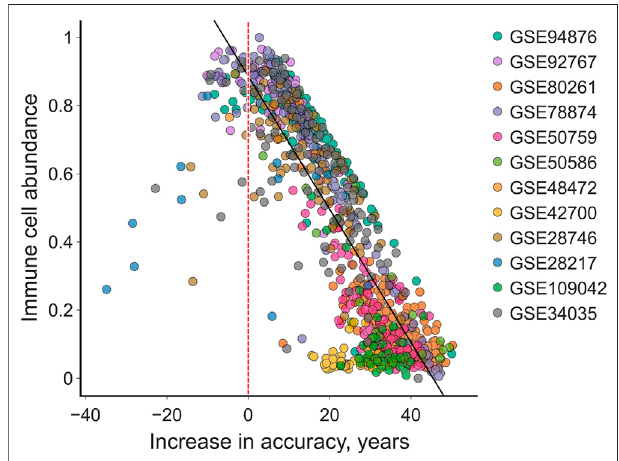
FIGURE 4 | The “ total age-transformed ” adjustment increases the age prediction accuracy in individual samples by up to 50 years in saliva samples. The absolute increase in accuracy is smaller in samples with higher immune cell count. Very few (5%) samples are predicted less accurately (left to the red vertical line) after the adjustment. Black line is the ordinary least squares regression, its R 2 is 0.72 and Pearson ’ s r is −